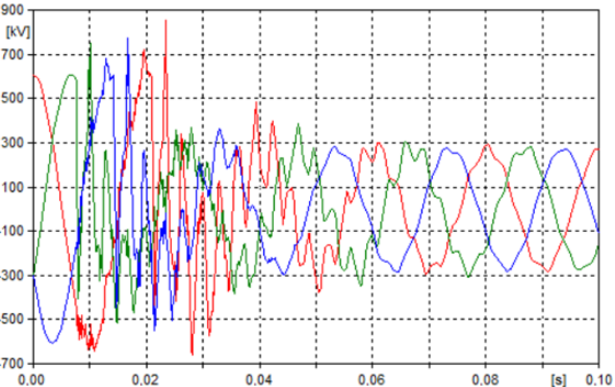
Figure 8. Voltage waveform of a multi-system line with different voltage levels for transmission line 400 kV.